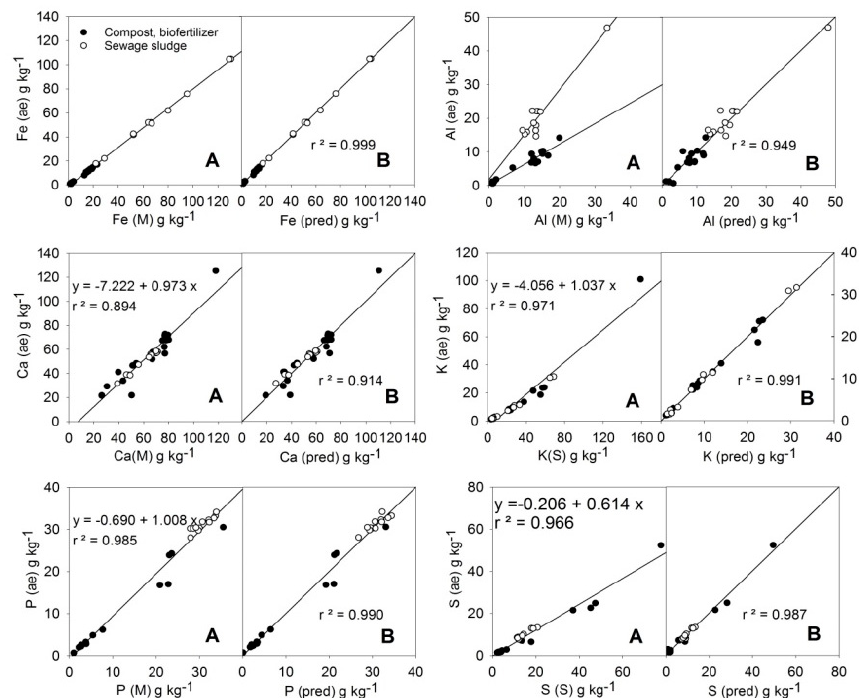
Figure 2. Relationships of PXRF readings of the major elements Fe, Al, Ca, K, P, and S and their aqua regia -extractable contents in training samples of organic amendments ( A ), and the adjustments of the predictions ( B ) of their aqua regia -extractable contents using the following multiple linear equations (Table 4): [Fe(pred)] = − 0.242 + 0.804[Fe(M)] − 0.010[Si(M)]; [Al(pred)] = 2.077 + 1.622[Al(M)] − 0.138